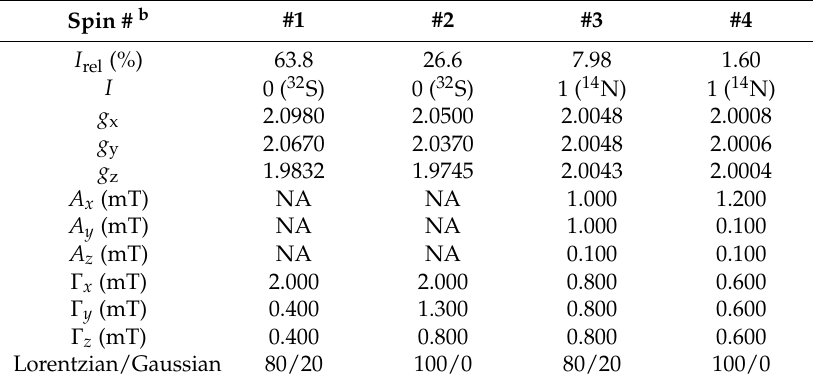
Table A3. Parameters for simulated spectrum of δ -salt under irradiated condition a